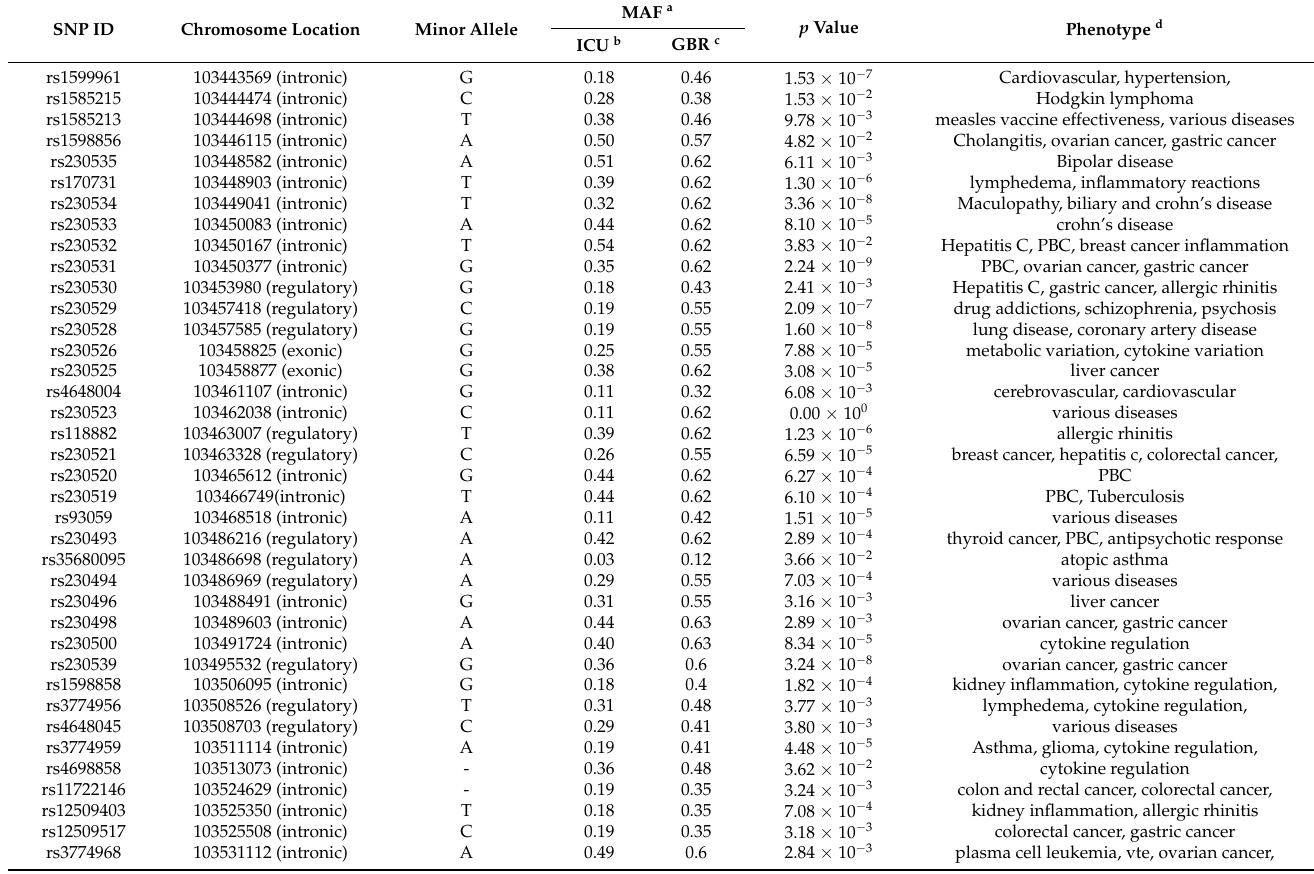
Table 2. Allele frequencies and association with severe AH1N1pdm2009 for SNPs previously reported to be associated with